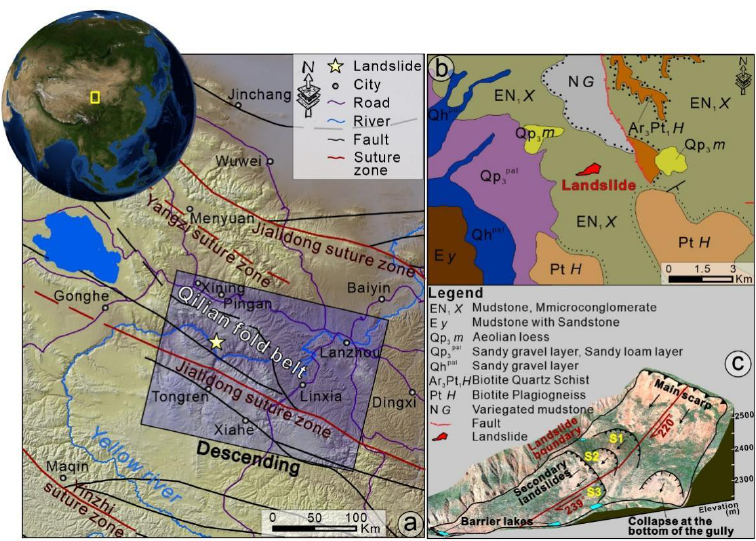
Figure 1. ( a ) Map showing the location of the study area. ( b ) Geological map of the study area. ( c ) Three-dimensional view of the landslide.